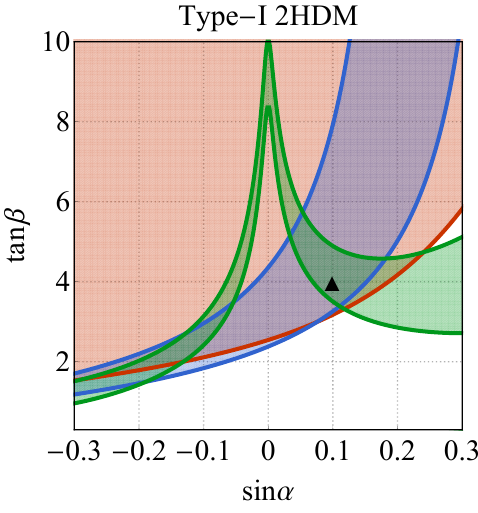
Figure 10 . Constraints on the type-I 2HDM in the case of the triangle ( N ) benchmark sce- nario (3.3). The colour coding resembles the one of (cid:12)gure 2. strength of around 66 fb (7 fb) for pp ! A ! ZH ( Z ! ‘ + ‘ (cid:0) ) in the H ! b (cid:22) b ( H ! (cid:28) + (cid:28) (cid:0) ) p channel at s = 13